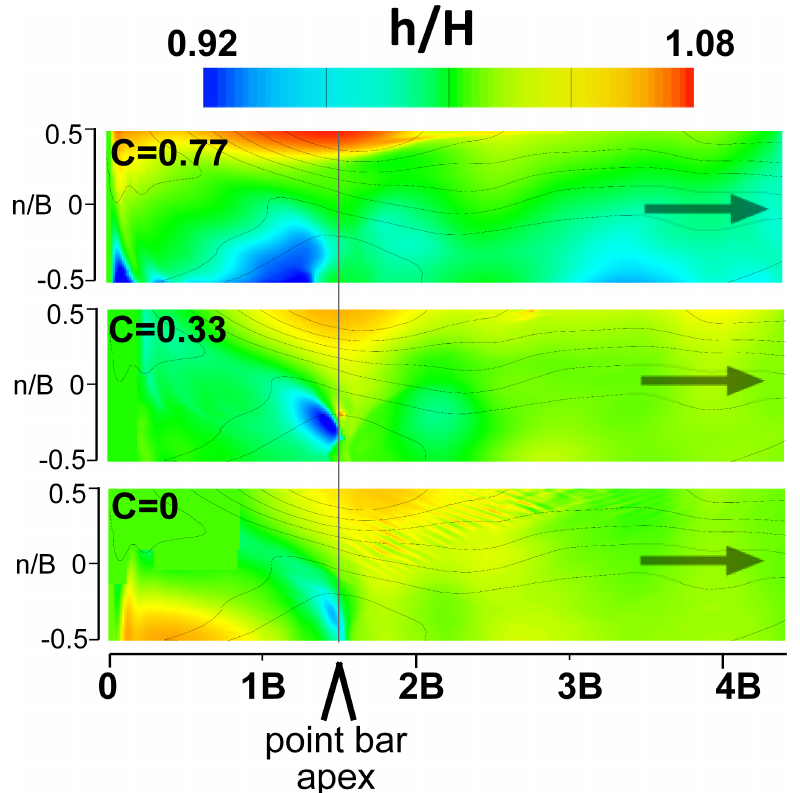
Figure 2. Flow surface elevation ( h ) normalized by H at C = 0.77, C = 0.33, and C = 0 conditions. n denotes the lateral coordination with n = 0 at channel center and B denotes the channel width.